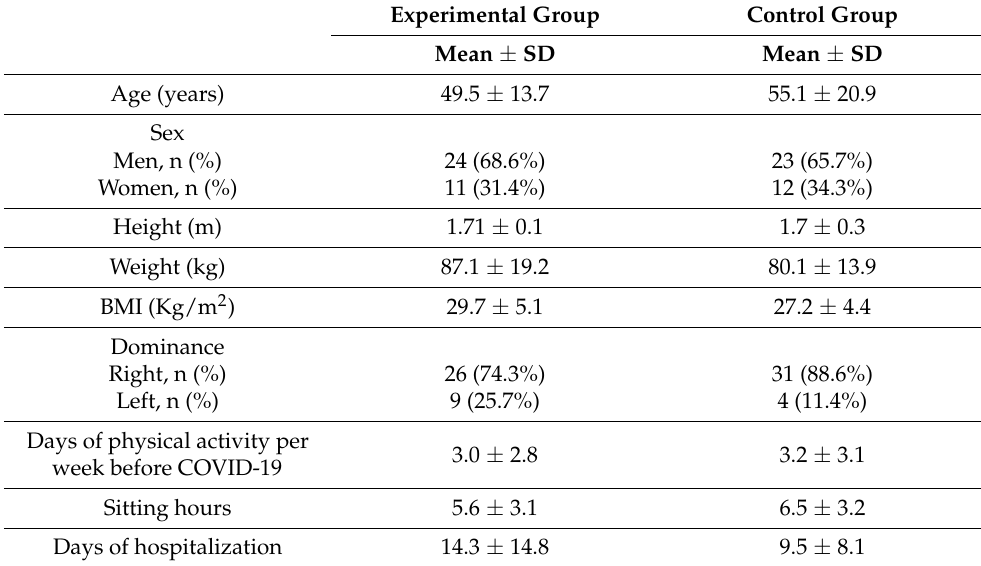
Figure 2. Flow diagram of participants during the study. Figure 2 . Flow diagram of participants during the study. Table 1. Baseline features of both